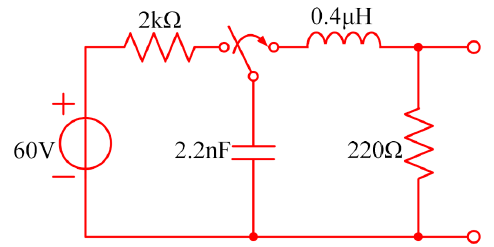
Figure 8. Circuit of impulse